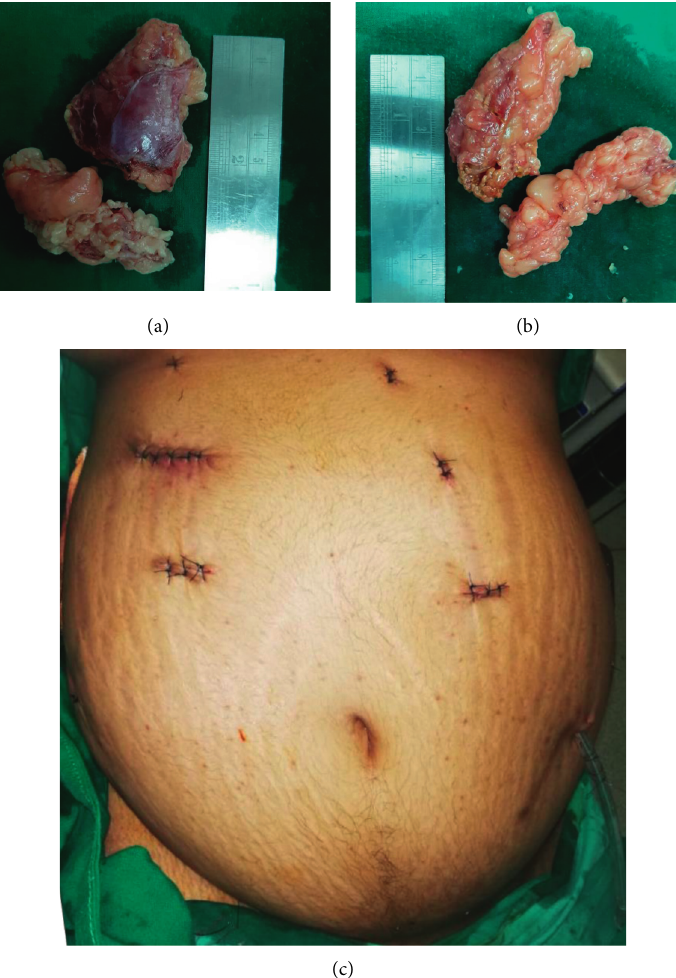
Figure 2: (a) Right adrenal gland with perinephric fat. (b) Left adrenal gland with perinephric fat. (c) Port placement and surgical wounds.